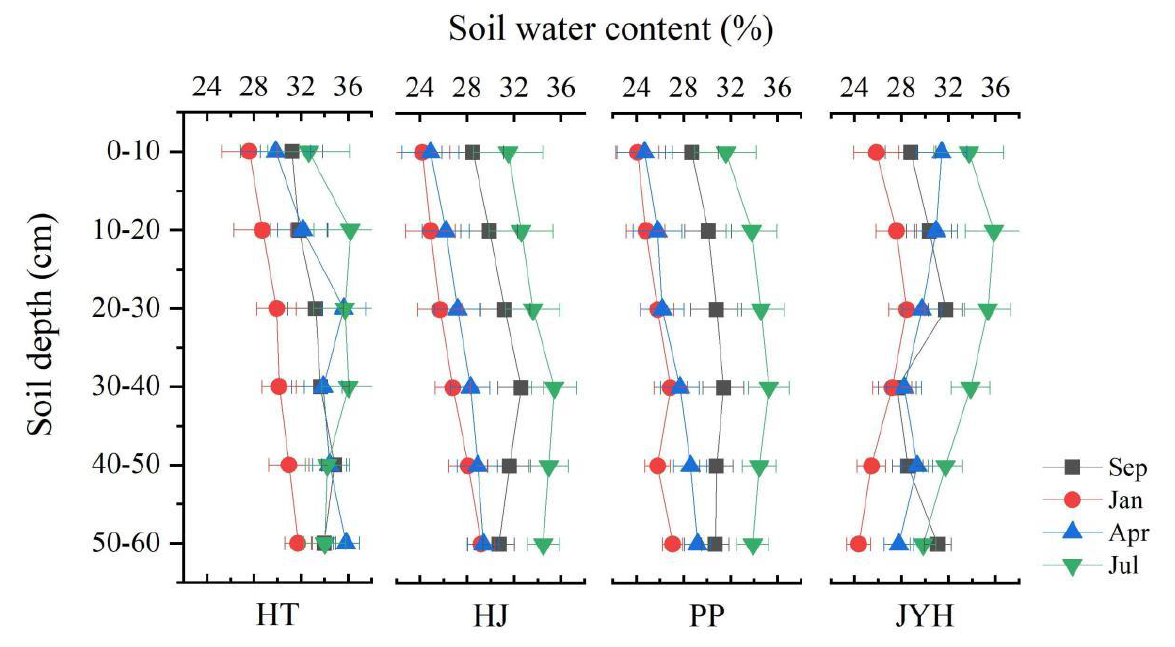
Figure 5. Changes in soil water content between HT, HJ, PP, and JYH in 0–60 cm section. The error bar represents the standard deviation.